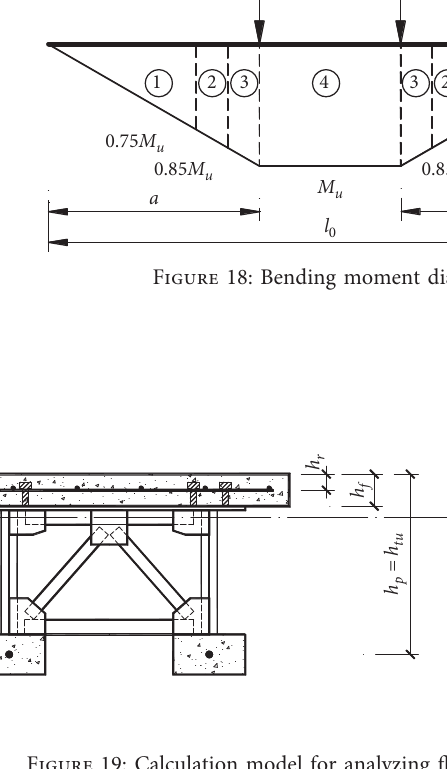
Figure 19: Calculation model for analyzing flexural